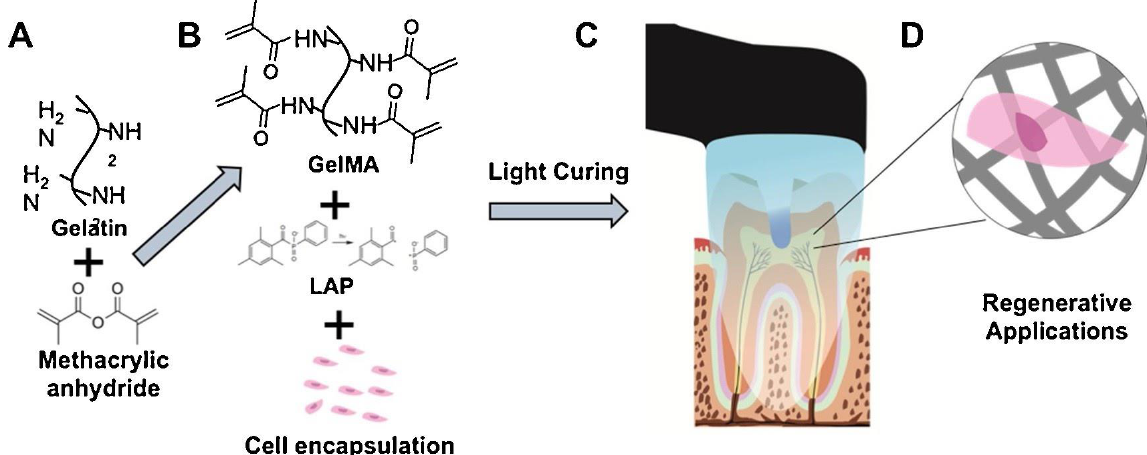
Figure 6. Photopolymerizable Cell-Laden Gelatin Methacryloyl Hydrogels for Regenerative Endodontics. Example of application of GelMA hydrogel in regenerative dentistry. ( A ) Synthesis of GelMA macromer ( B ) Cell encapsulation ( C ) Example intracanal hydrogel loading and photopolymerization ( D ) The resulting cell-laden hydrogel material. Note that although the schematic depicts an example for regenerative endodontics, the material can be used for any application of intra-oral regeneration, such guided periodontal regeneration, alveolar bone growth and others. Reprinted from [145] with permission from Elsevier.